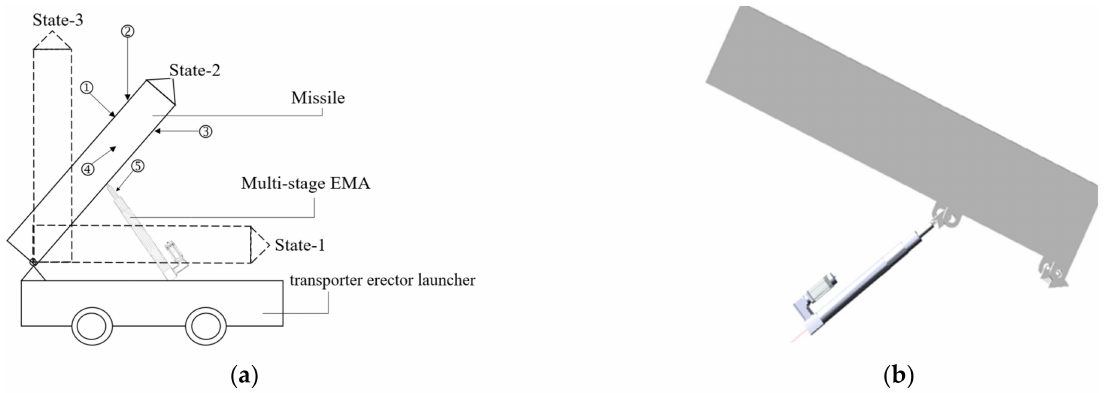
Figure 8. ( a ) Schematic diagram of missile erection process; ( b ) ADAMS model of EMA erecting